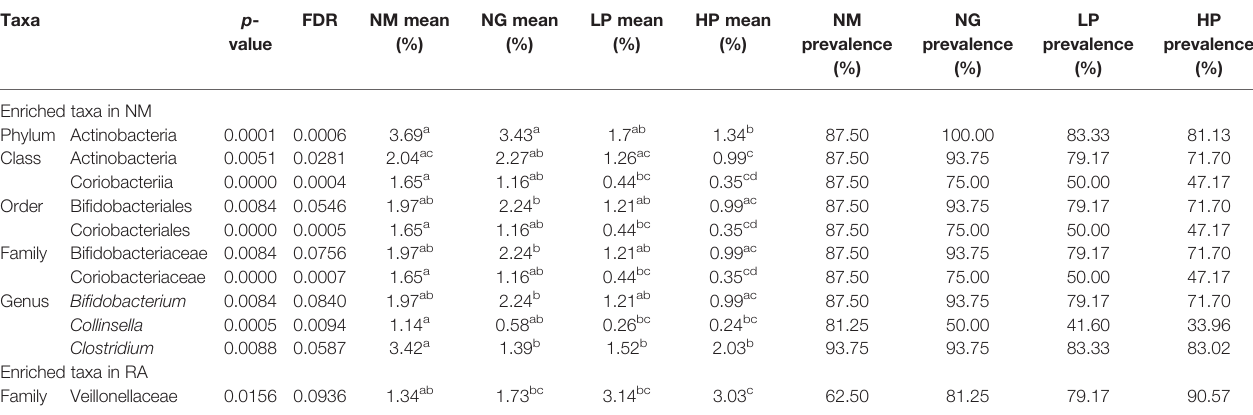
TABLE 2 | Differentially enriched taxa in rheumatoid patients and healthy